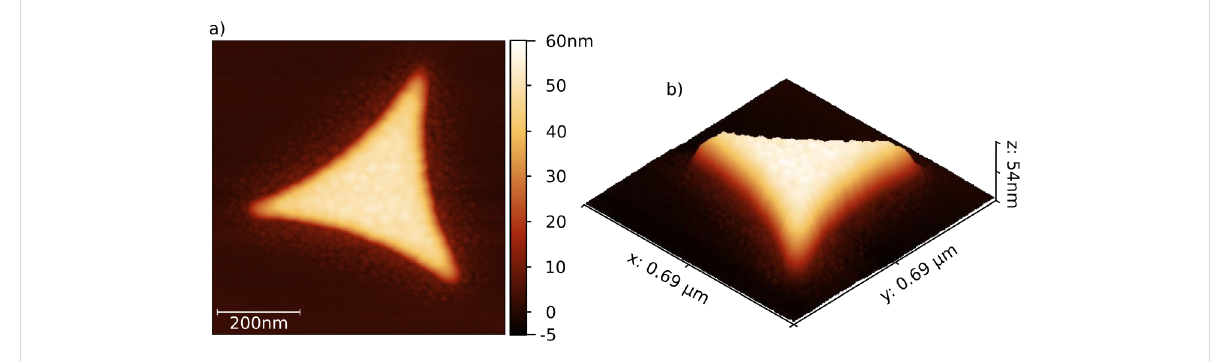
Figure 4: AFM image of a colloid lithography triangle. (a) Top view; (b) 3D image.